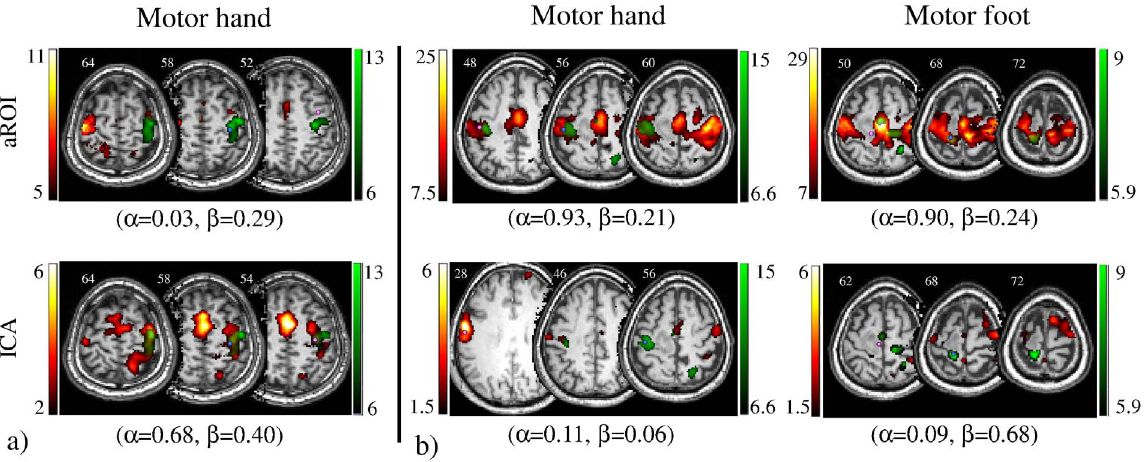
Figure 2. Concordance between task-based (tb-fMRI, in green) and resting-state (rs-fMRI, in red) fMRI maps computed with aROI (top row) and ICA (bottom row). Overlap sensitivity ( a ) and specificity ( b ) of rs-fMRI with respect to tb-fMRI, obtained with operator-dependent thresholds, are reported. Light blue circle represents the Centre of Mass (CoM) of tb-fMRI, and pink circle represents the CoM of rs-fMRI. Images are shown in neurological convention (left is left) and MNI coordinates are reported on top of each slice. a) For Case 4 concordance between rs-fMRI and tb-fMRI was better with ICA, while (b) for Case 12 was better with aROI.